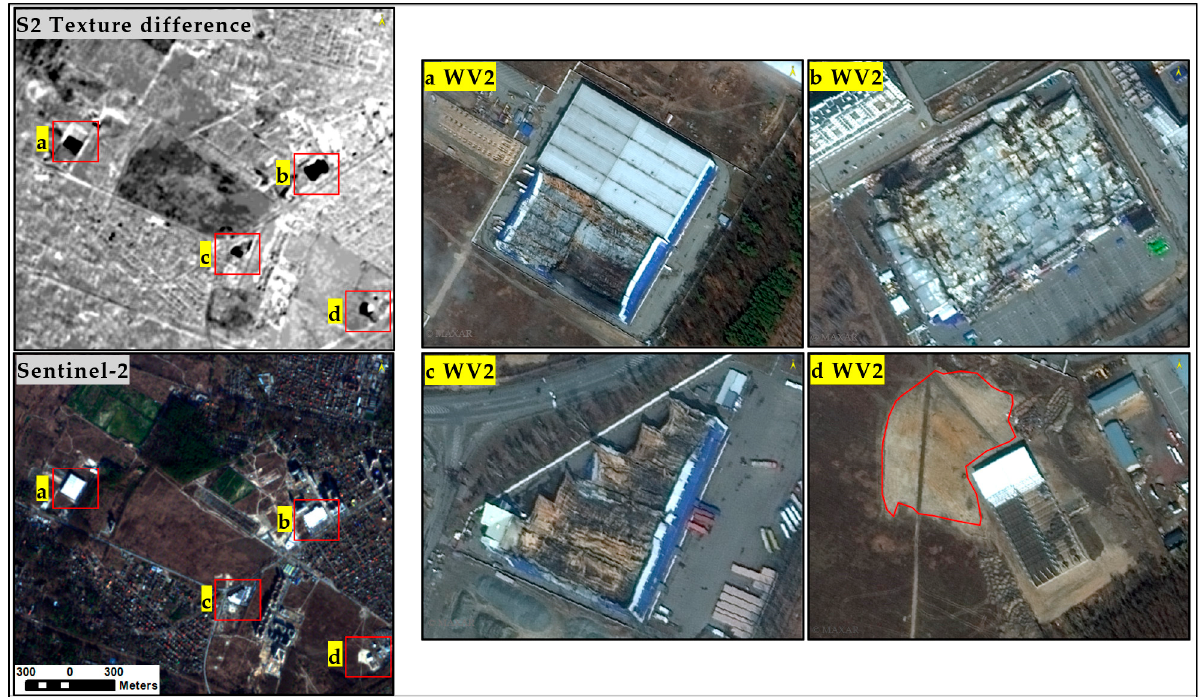
Figure 6. The GLCM texture difference and the corresponding optical images. ( a – d ) are selected examples that have significant texture changes, and those locations are shown on the WorldView-2 image.